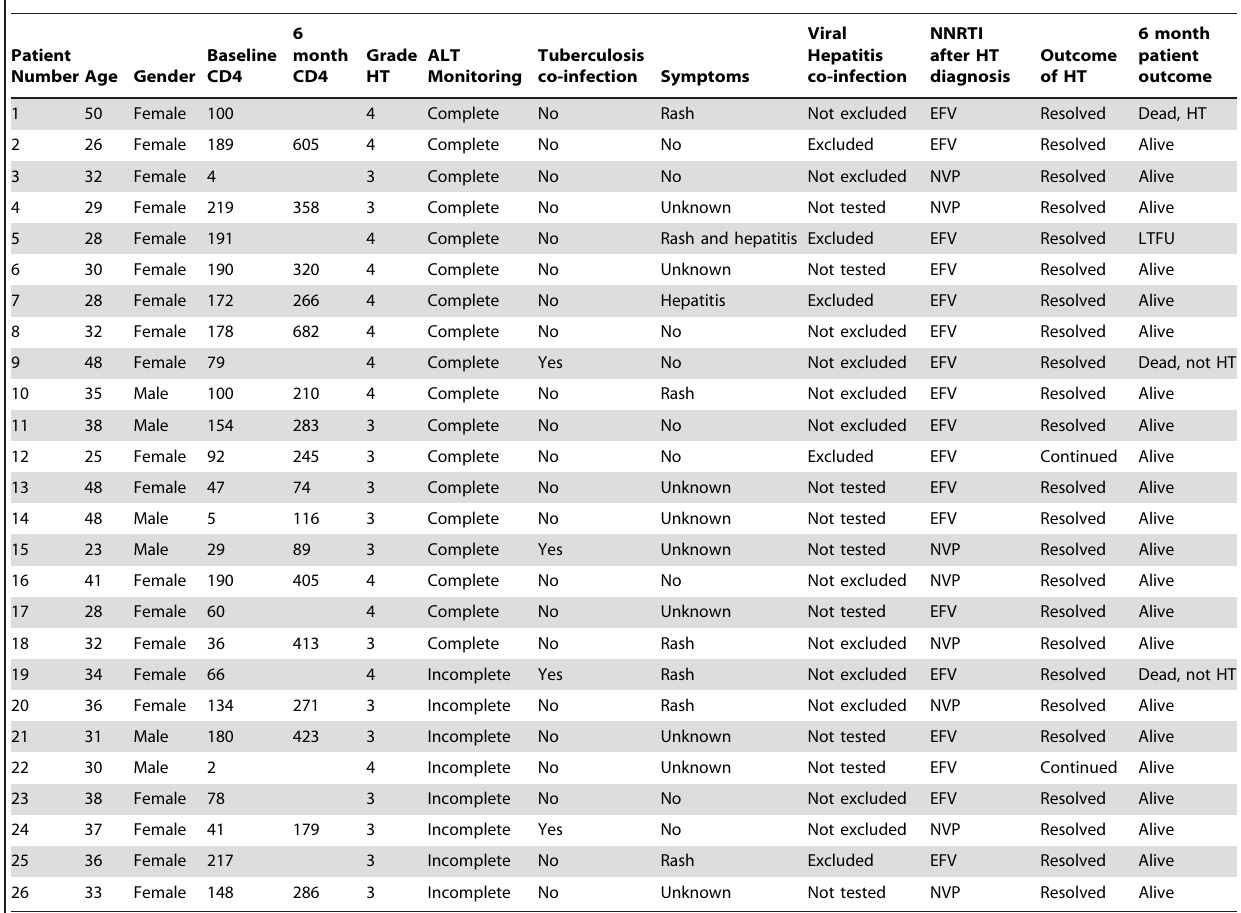
Table 3. Patients with early hepatotoxicity on nevirapine-based antiretroviral treatment.